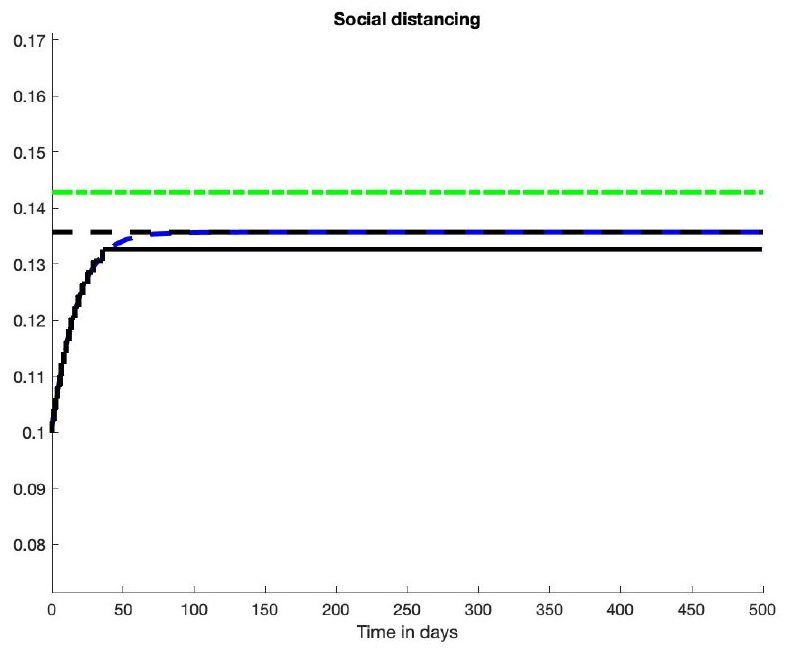
Figure 7. Scenario 4: Control. β , β ∗ (- -,blue), γ (- ., green) and β acceptable (- -, black).